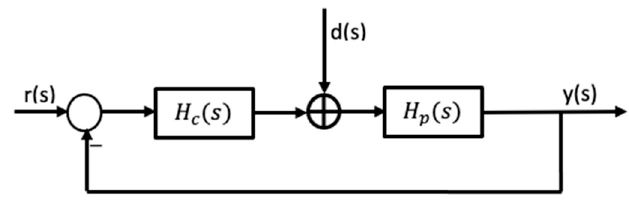
Figure 1. Closed-loop system diagram.